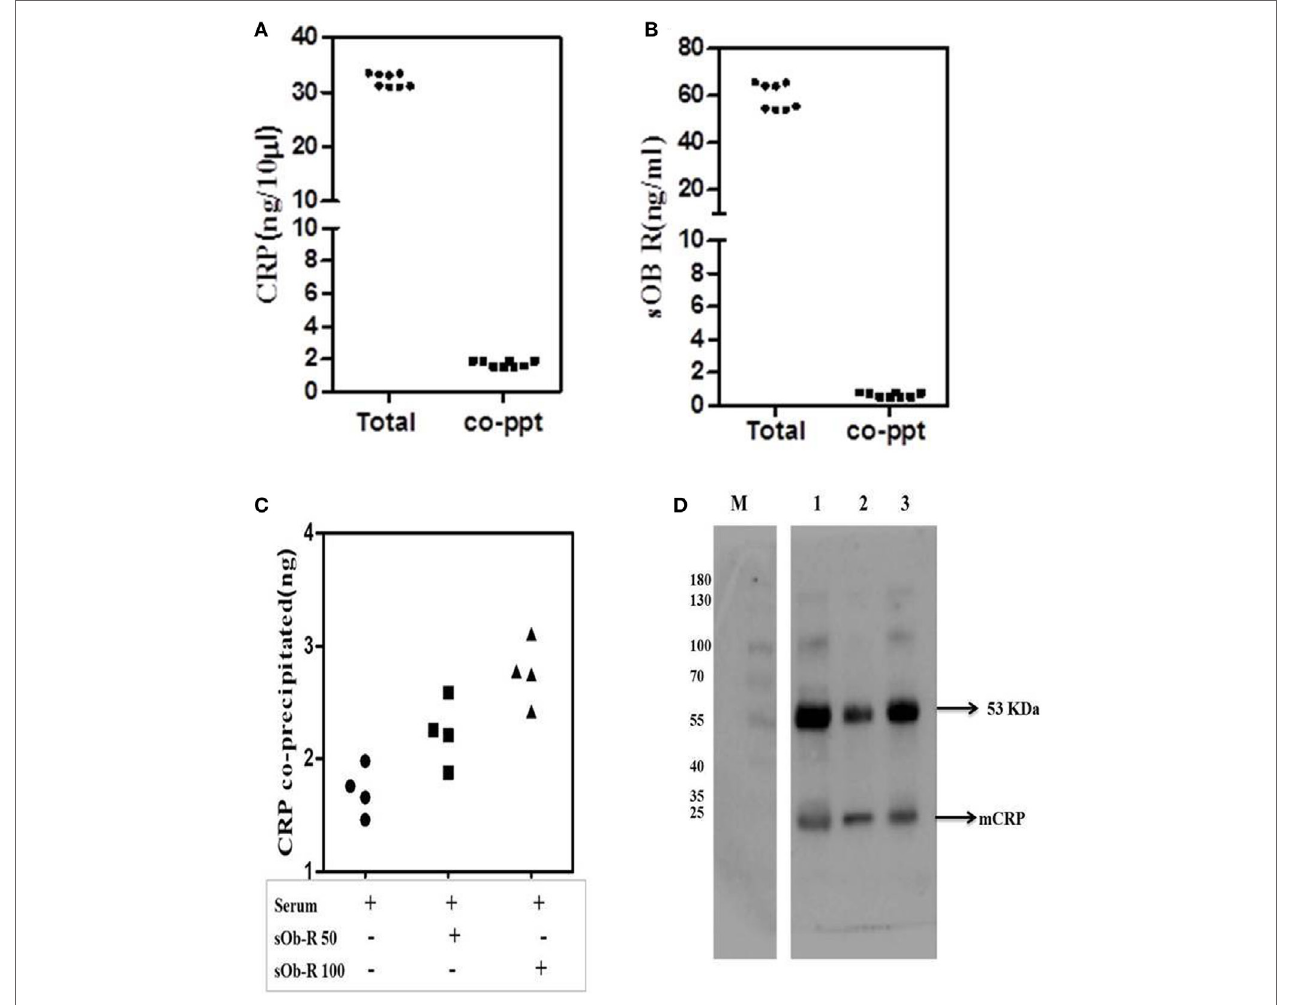
FigUre 6 | Co-precipitation of soluble leptin receptor (sOb R) and C-reactive protein (CRP) from serum. (a) Co-precipitation of CRP with sOb R: sOb R was immunoprecipitated from fresh human serum and the amount of CRP present in the immunoprecipitate was assayed by ELISA. Total CRP in serum was also assayed. Scatter plot represents results of multiple experiments in replicates. (mean ± SD of total CRP was 32.18 ± 1.24 and that of co-precipitated CRP was 1.74 ± 0.17). (B) Co-precipitation of soluble leptin receptor with CRP: CRP was immunoprecipitated from freshly isolated human serum and the amount of soluble leptin receptor present in the immunoprecipitate was determined by ELISA. Total soluble leptin receptor in serum was also determined. [mean ± SD of total soluble leptin receptor (sOb R) was 59.6 ± 5.6 and that of co-precipitated sOb R was 0.67 ± 0.14]. (c) Co-precipitation of CRP from serum spiked with different concentrations of soluble leptin receptor. To 50 µl of freshly isolated serum, different concentrations (50, 100 ng) of leptin receptor were added, incubated for 30 min, immunoprecipitated leptin receptor, and estimated the amount of CRP co-precipitated by ELISA as above. Scatter plot represents results of multiple assays and shows an increase in co-precipitated CRP with increase in concentrations of added leptin receptor. (D) Immunoblot analysis of co-precipitated CRP. sOb R was immunoprecipitated from human serum, subjected to 7.5% SDS-PAGE followed by Western blotting, probed with anti-CRP, and located by ECL as described in the text. Lane 1: sOb R co-precipitate. Lane 2: immune-precipitated CRP from sOb R co-precipitate. Lane 3: immunoprecipitated CRP from whole serum. M: molecular weight markers.